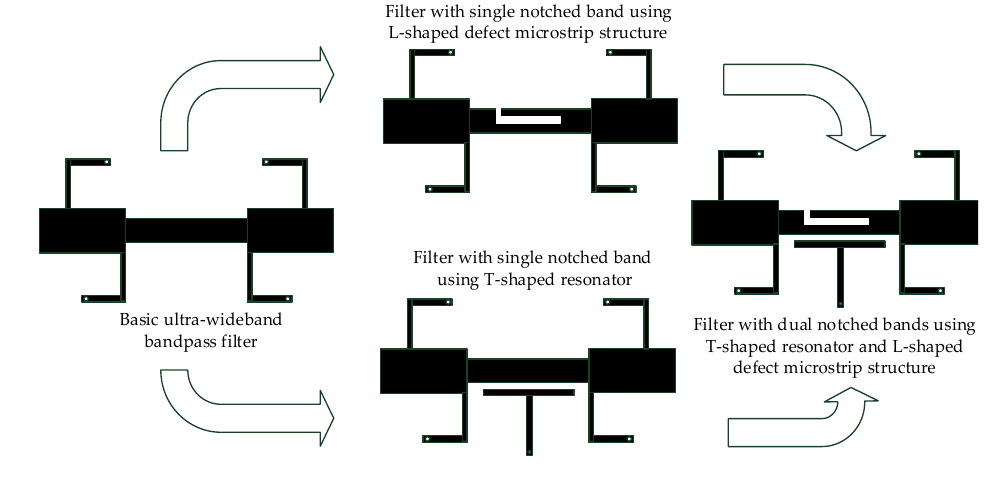
Figure 2. Design process of the dual notched bands filter.